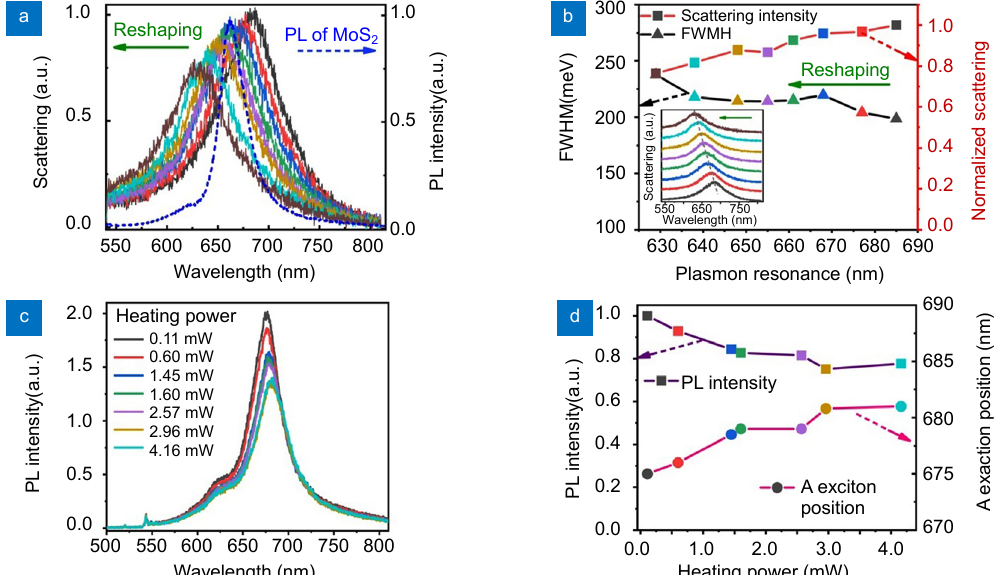
Fig. 2 | Photothermal reshaping of a single GNR on the glass substrate. ( a ) Scattering spectra of a GNR on the glass tuned by photothermal reshaping effect through controlling the illumination power. The blue-dashed line in (a) is the photoluminescence spectra of the MoS 2 monolayer. ( b ) FWHM and intensity of scattering spectra during the photothermal reshaping. Inset shows the blue-shift of the plasmon resonance of GNR. The color in (b) corresponds to the color of the scattering spectra in (a). ( c ) Influence of laser power (~0.11 mW to ~4.16 mW) on monolayer MoS 2 on the glass. ( d ) PL intensity and A exciton position changes during the photothermal reshaping. Excitation laser wavelength: 532 nm. Excitation power: 110 μ W. Integration time: 0.5